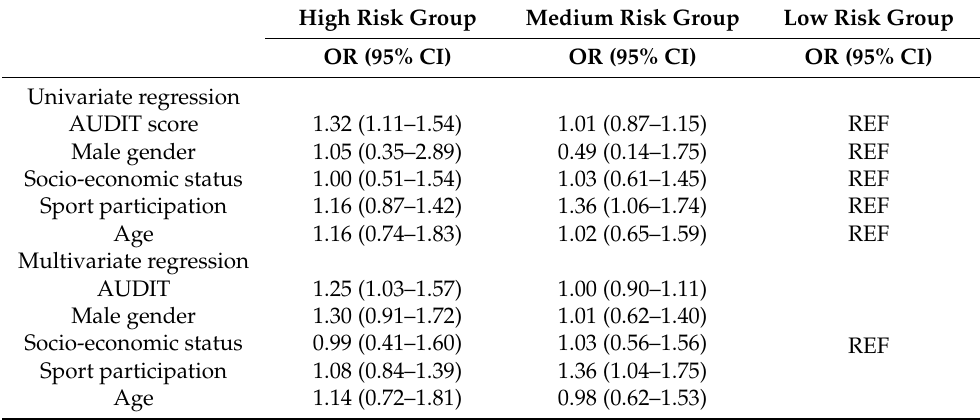
Table 2. Univariate and multivariate multinomial regression results for criterion “risk of PAL-decline over the study course” (low risk of PAL decline was set as the referent category). High Risk Group Medium Risk Group Low Risk Group OR (95% CI) OR (95% CI) OR (95%